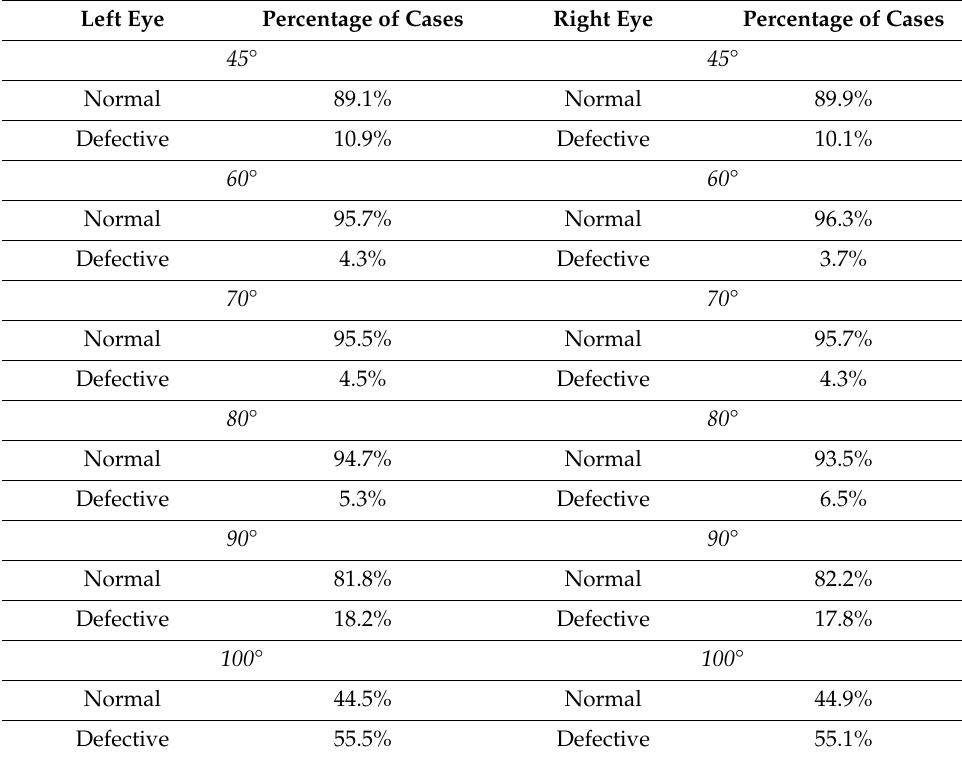
Table 3. Results of peripheral campimetry tests under di ff erent field amplitude angles [45 ◦ to 100 ◦